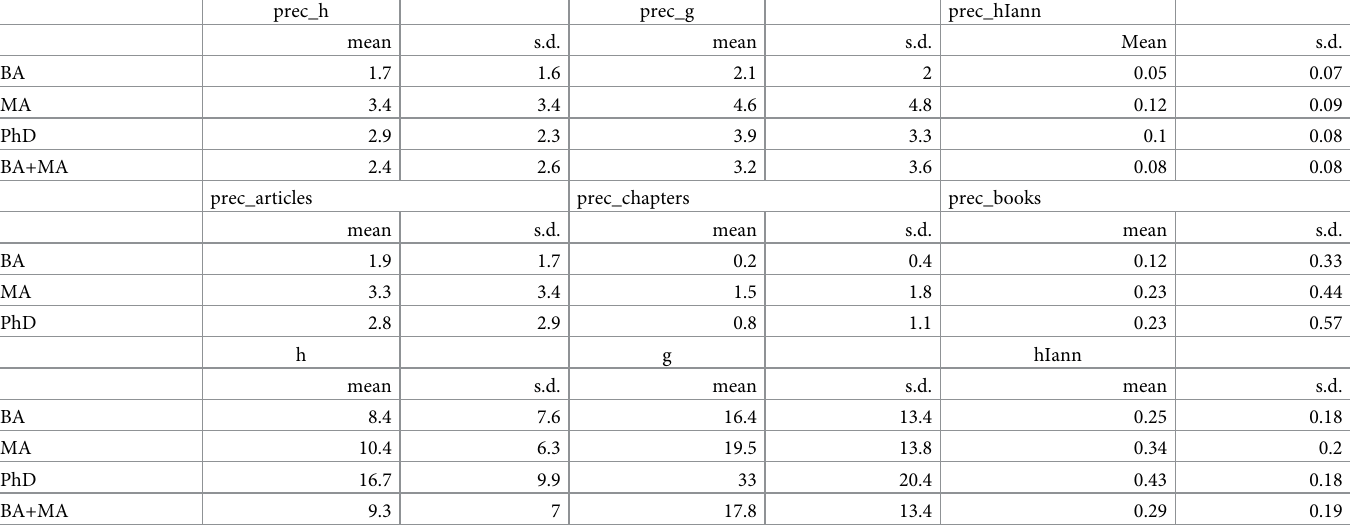
Table 3. Precocity and career bibliographic measures (mean, standard deviation [s.d.]) by program level for PhD year < 2002. 1